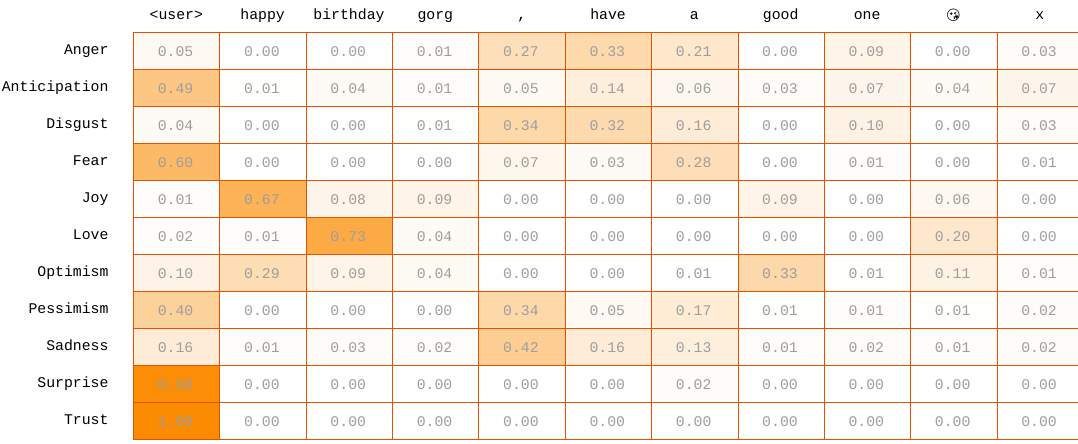
Figure 8. Attention visualization example. Golden labels are { joy , love , optimism } and predicted labels are { joy (0.98) , love (0.91) optimism (0.95) }.